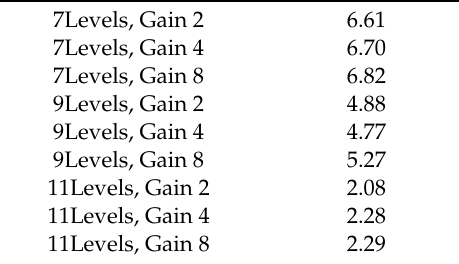
Table 12. THD% of voltages for nine outputs.